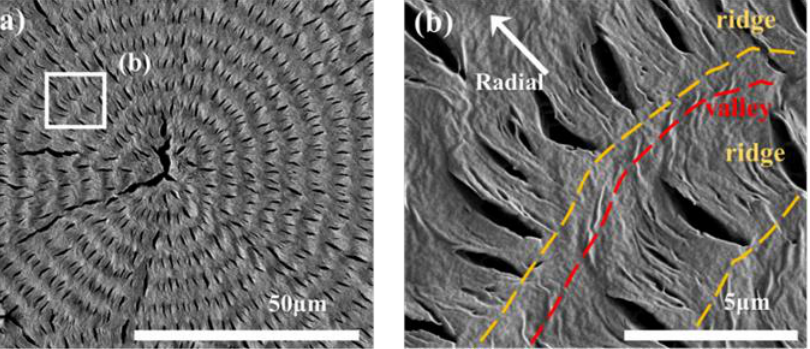
Figure 2. SEM graphs for methanol-etched top surface of PBA/PEO (90/10) crystallized at 30 °C: ( a ) top surface of an entire spherulite, ( b ) zoom-in to lamellae on top surface displaying periodic tail-bending/twisting to the circumferential direction at the valley.